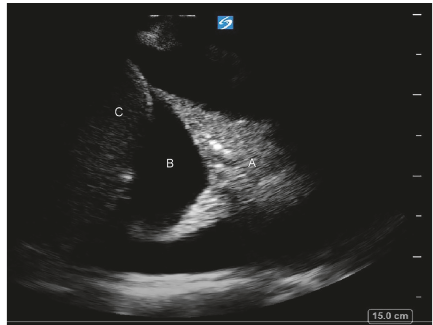
Figure 3: Chest US prior to thoracentesis demonstrating anechoic pleural fluid (B). A = collapsed lung parenchyma; C = liver.